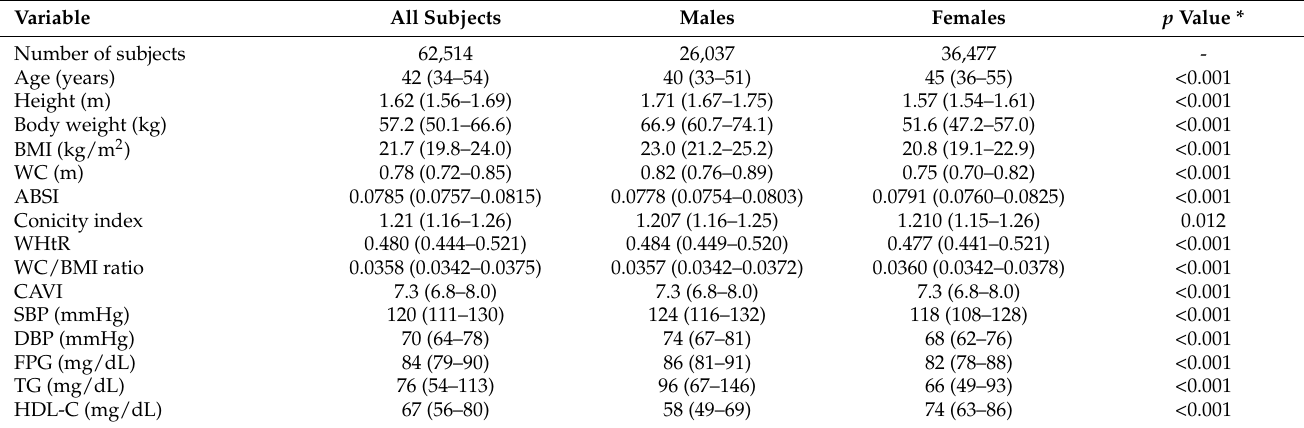
Table 1. Clinical and biochemical characteristics of male and female